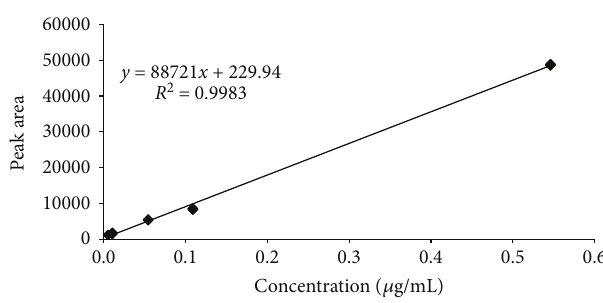
y = 88721 x + 229.94 R 2 = 0.9983